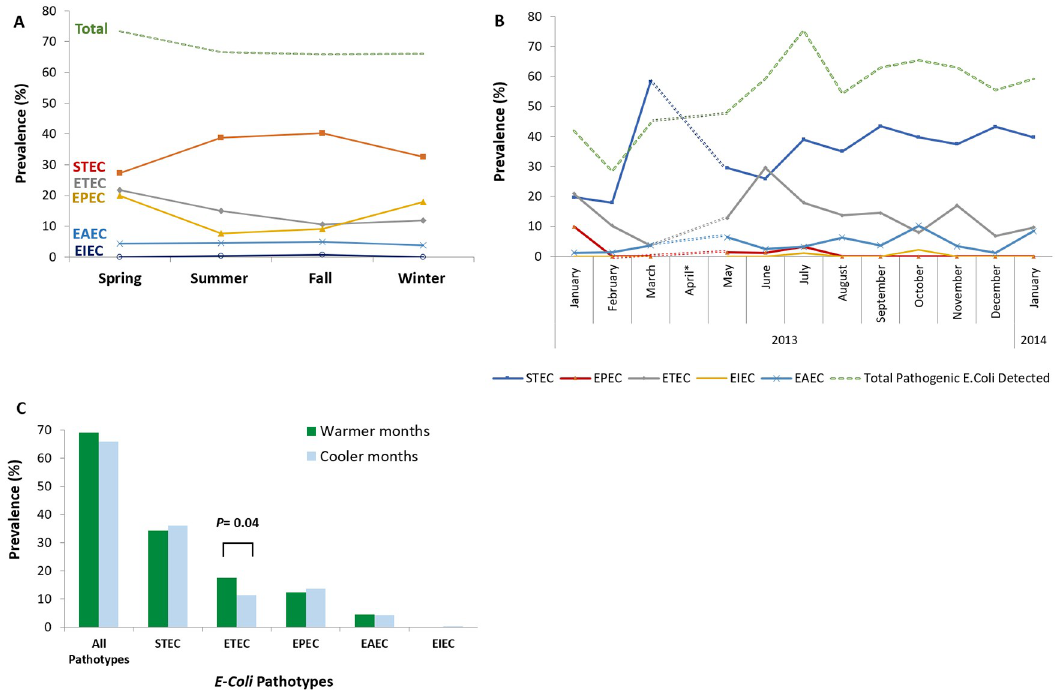
Fig 2. Seasonal trend of E . coli pathotypes in Iran. (a) Frequency of five E . coli pathotypes in four seasons. STEC was more prevalent during summer and fall, and ETEC usually showed a peak during spring and summer. Remarkable seasonal trends could not be observed for other pathotypes, probably due to scarcity of available data. (B) Frequency of five E . coli pathotypes in different months of a year. STEC showed a peak in March and ETEC showed a peak in June. Remarkable monthly trends could not be observed for other pathotypes, probably due to availability of very few samples. (C) Difference in the frequency of five E . coli pathotypes in warmer (spring and summer) versus cooler seasons (fall and winter). In overall, E . coli pathotypes were more frequently observed in warmer than cooler seasons but the difference was not statistically significant ( P value = 0.321). This pattern was observed for the ETEC and EAEC pathotypes and was statistically significant for ETEC ( P value = 0.04). STEC and EPEC were more frequently observed in cooler than warmer seasons but the difference, was negligible and not statistically